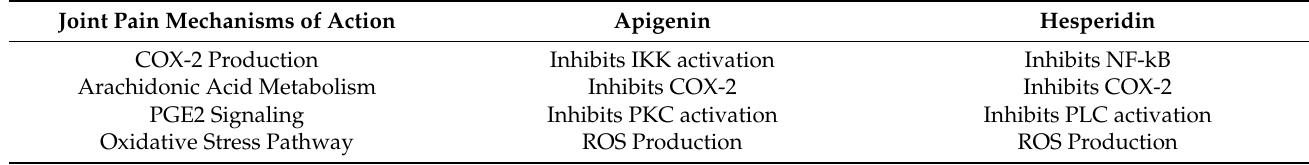
Table 6. Summary of effects of apigenin and hesperidin on mechanisms of joint